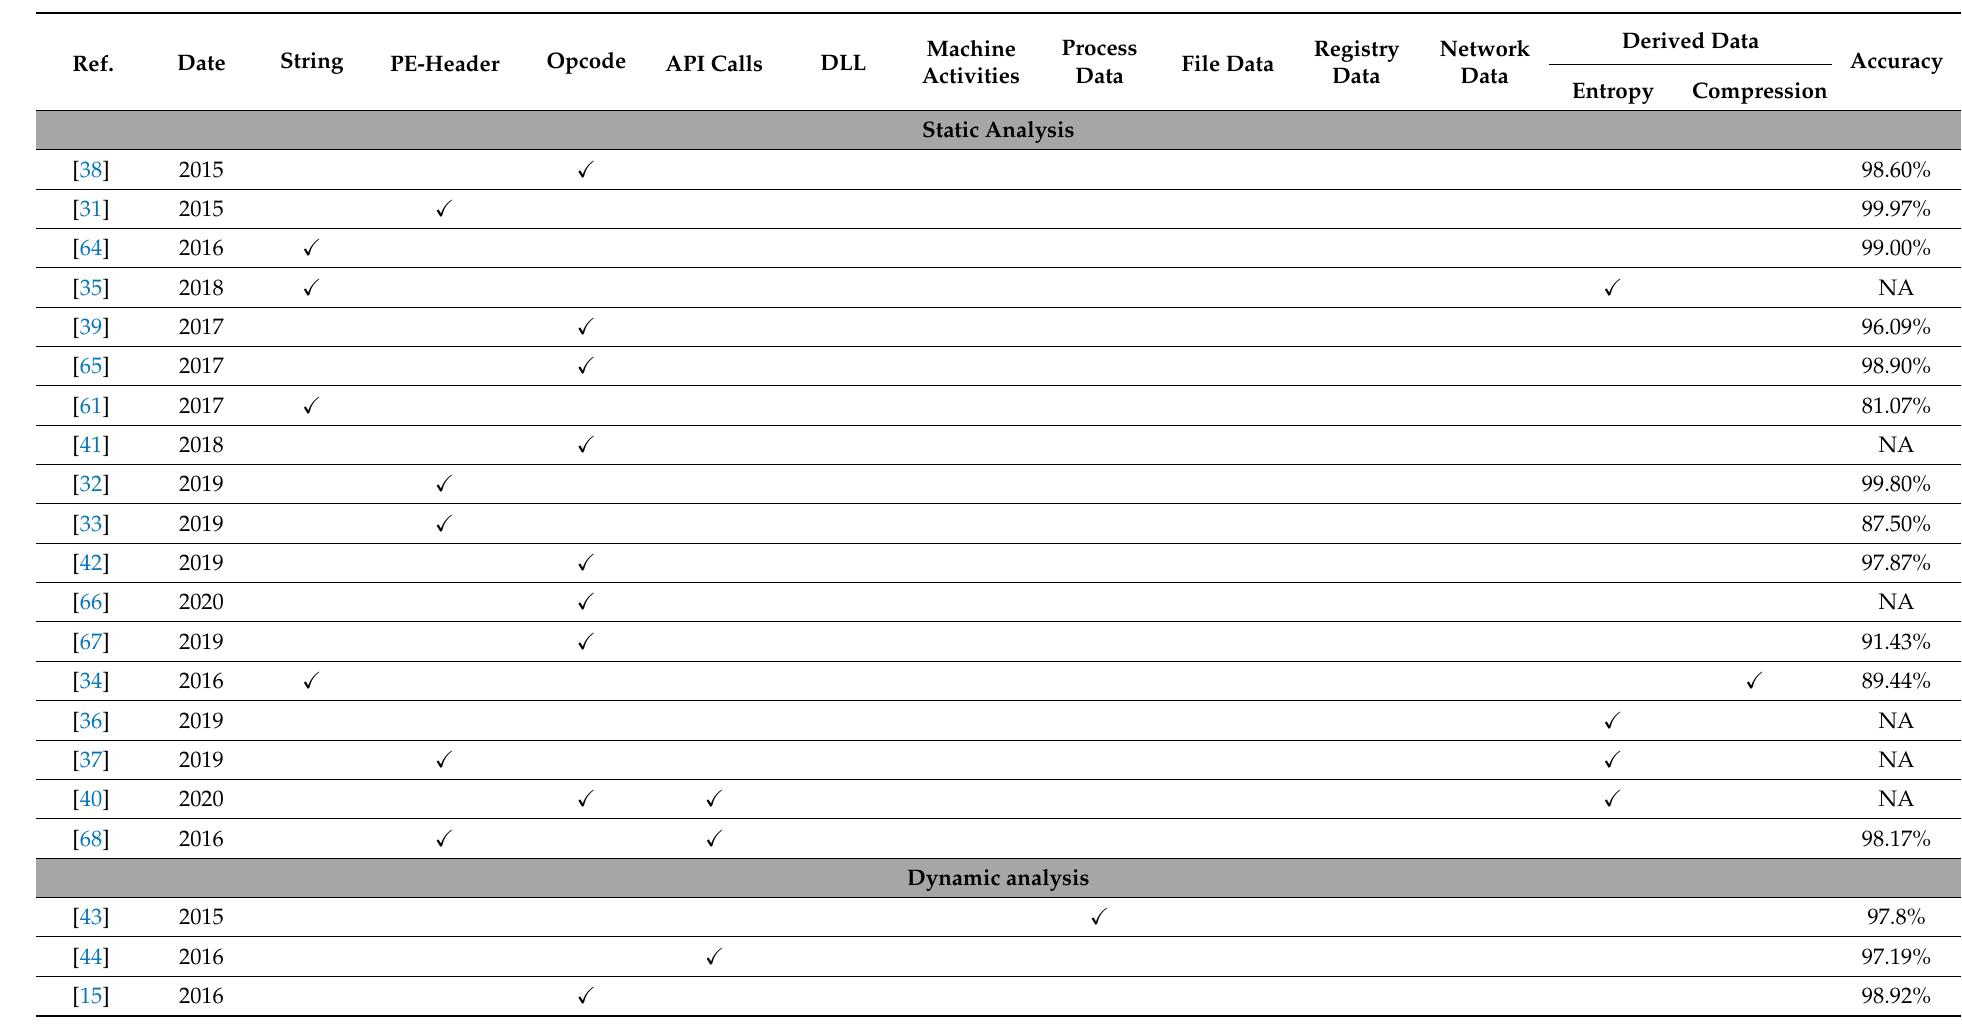
Table 2. The relation between analysis approaches and data